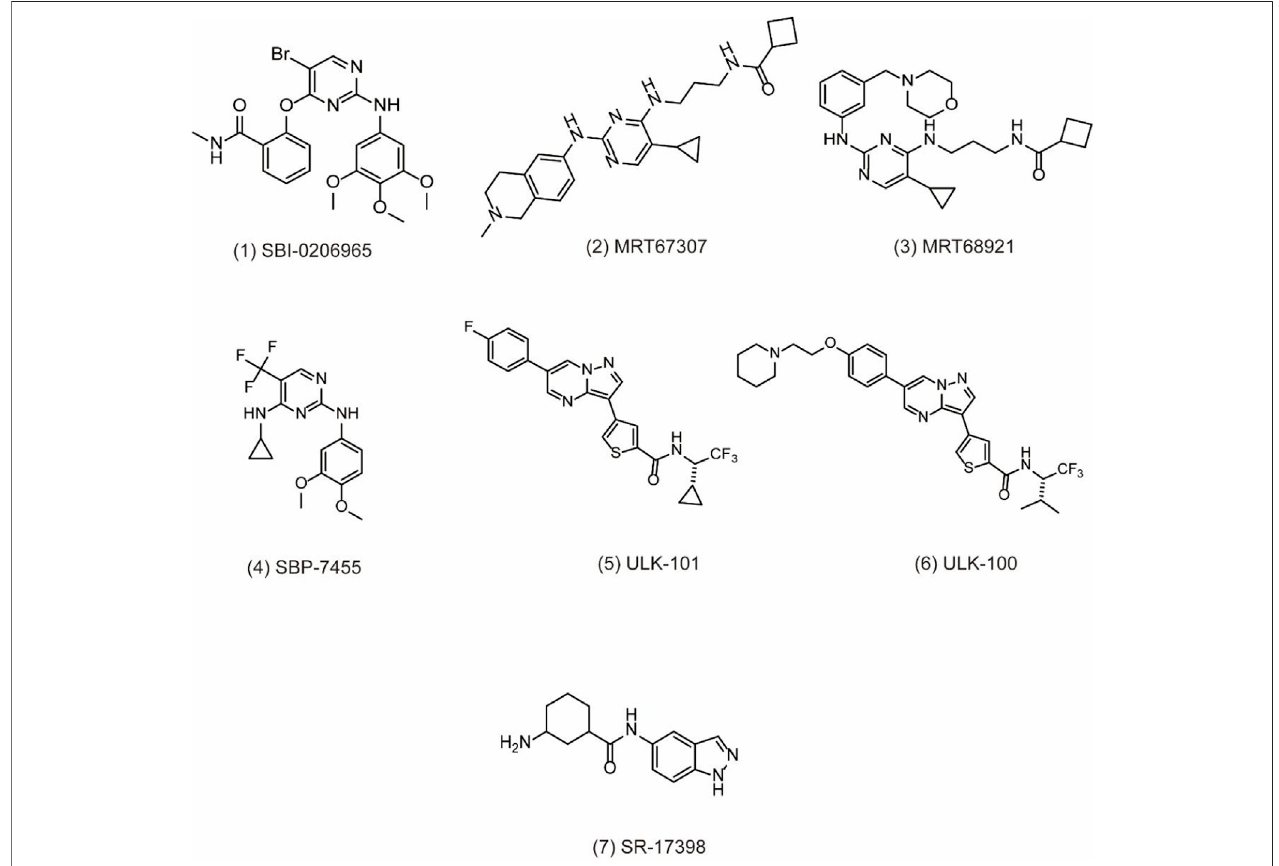
FIGURE 2 | Chemical structures of 1 – 7 as inhibitors of autophagy by targeting ULK1.